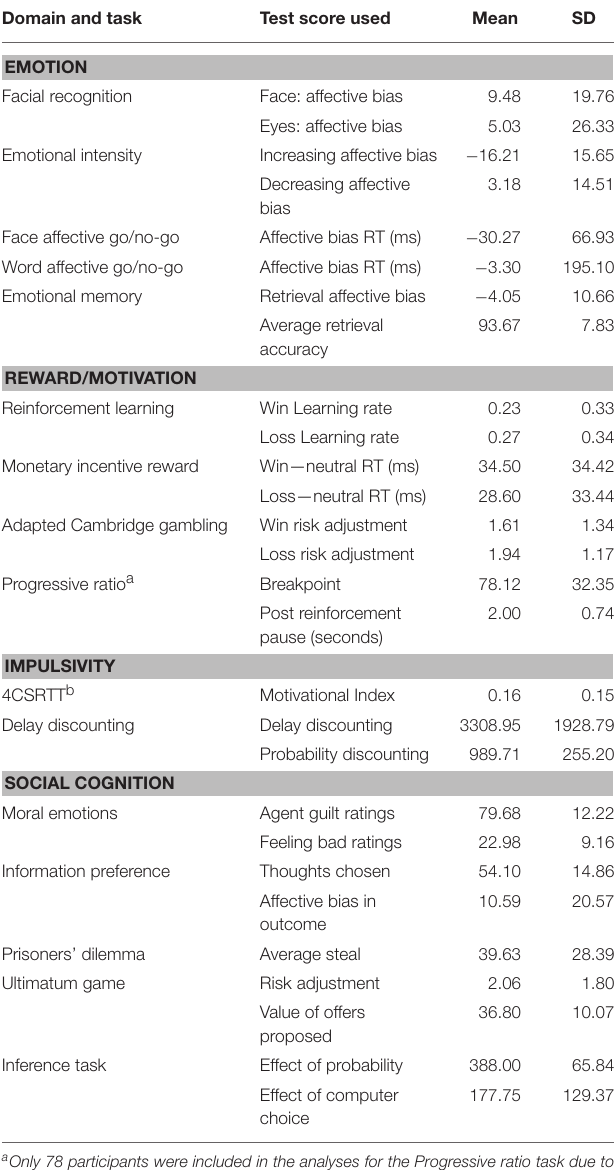
TABLE 3 | Summary of the means and standard